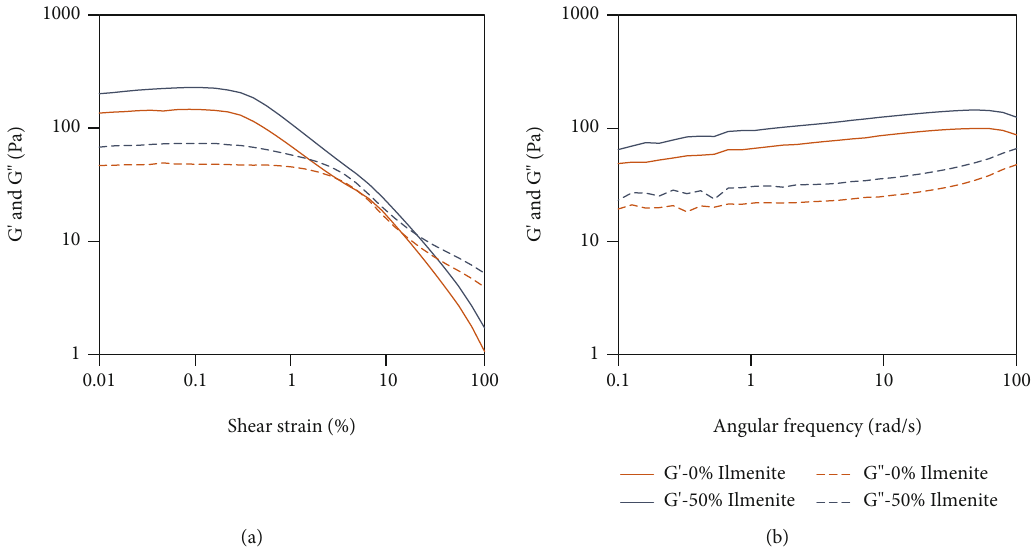
Figure 9: Results of (a) oscillatory amplitude test and (b) frequency sweep test.